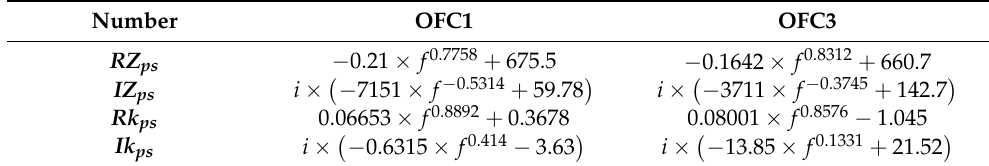
Figure 5. Measured results and curve fitting results of the complex wave number of OFC2: ( a ) Real part of measured results and curve fitting results of the complex wave number ( Rk ps = 0.04482 × f 0.9229 + 1.991); ( b ) Imaginary part of measured results and curve fitting results of the complex wave number ( Ik ps = i × 0.1032 × f 0.5992 − 6.626 ).